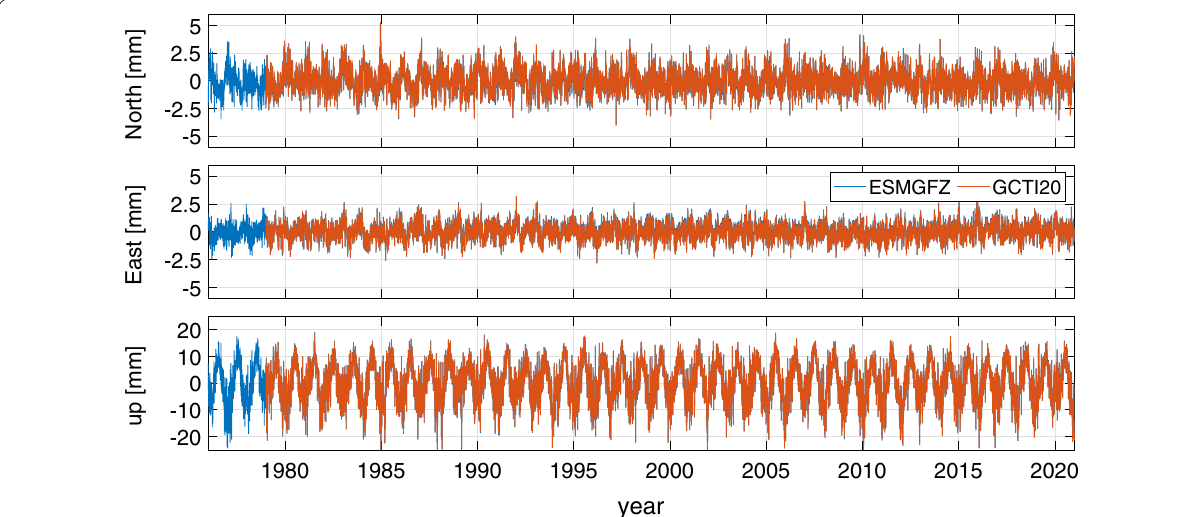
Fig. 1 Site displacements for non-tidal atmospheric loading (NTAL) in the CM-frame at the SLR station 1879 in Altay, Russia. Blue: ESMGFZ, red: GCTI20. Please note the different scale for the up